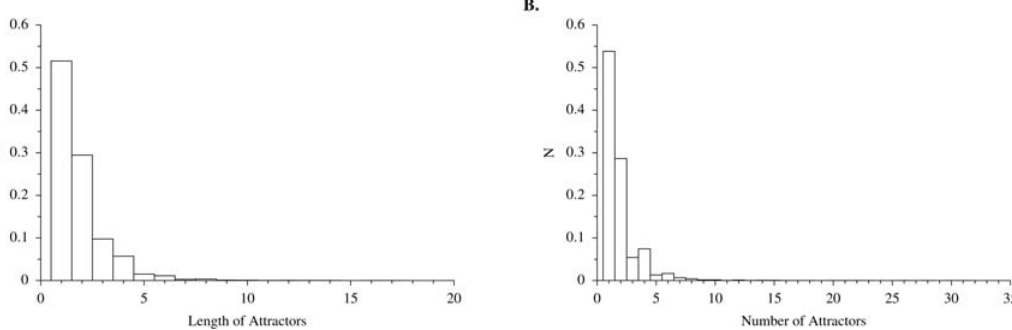
Figure 7. Length and number of attractors in networks of size N =10. (A) Frequency distribution of length of attractors, estimated from 40,000 randomly generated networks. The maximum attractor length in this sample was 31. (B) Frequency distribution of the number of attractors in each network, estimated from 80,000 randomly generated networks. The maximum number of attractors was 17 in this sample.